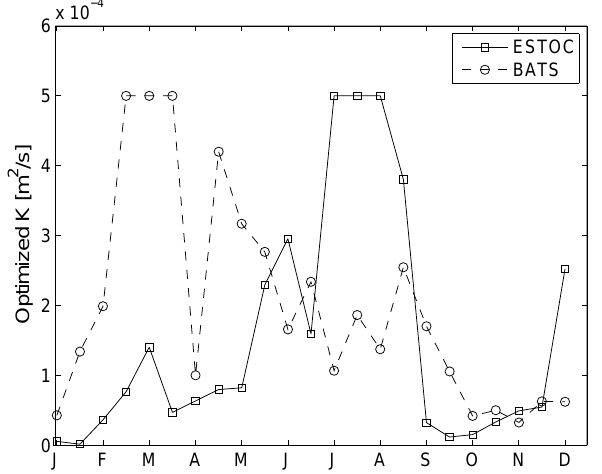
Fig. 4. Optimized diffusivity ( K ) computed for BATS and ESTOC. Values higher than 5 cm 2 s − 1 where set to 5 cm 2 s − 1 on account of numerical limitations in the biological source term calculations.